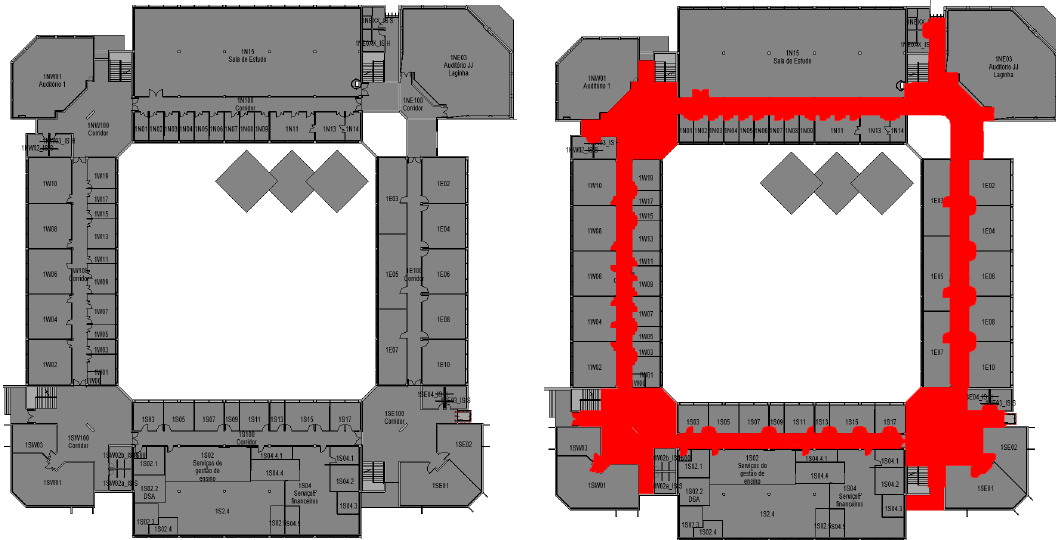
Figure 11. Floor plans generated from the Building Information Model (BIM) model for user visualization ( Left ); internal app pathfinding algorithm support with walkable areas in red ( Right ).